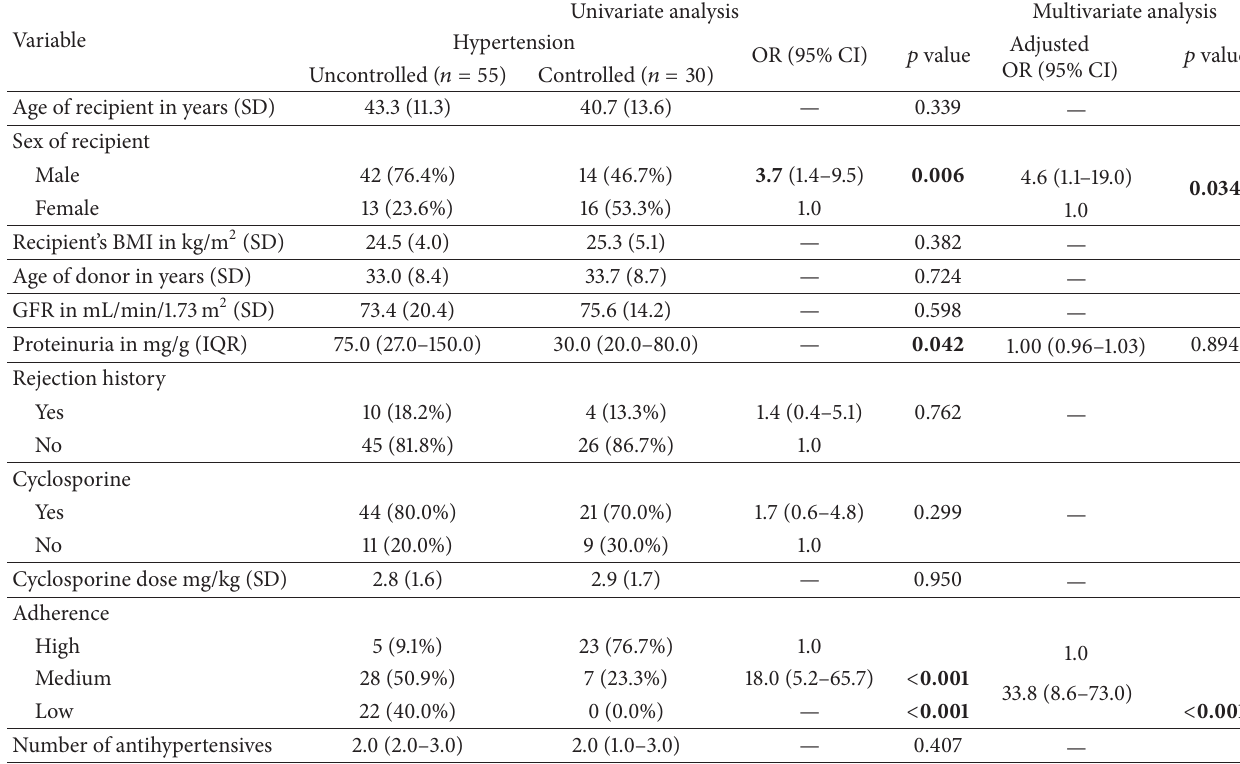
Table 2: Association between uncontrolled hypertension and selected